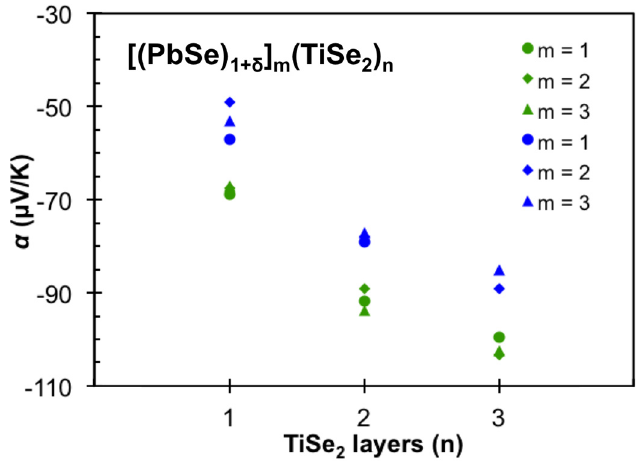
Figure 18. Seebeck coefficient ( α ) as a function of number of TiSe 2 layers (n). The magnitude of α is seen to increase with n, independent of m. Table 1 also contains room temperature resistivity and Seebeck coefficients for the 3: 3 and 1: 1 :2: 2 sample. The resistvity of the 3: 3 compound was found to be slightly higher than that of the 1: 1 :2: